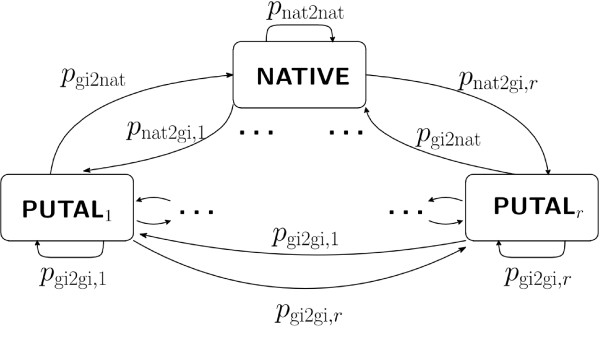
States and transition probabilities of SIGI-HMM's Markov chain. The state NATIVE represents genes which are unsuspicious with respect to synonymous codon frequencies. For ρ = 1, 2,..., r, the state PUTALρ models genes, whose codon usage resembles more the prevalences of genomes G
 MathType@MTEF@5@5@+=feaafiart1ev1aaatCvAUfKttLearuWrP9MDH5MBPbIqV92AaeXatLxBI9gBamrtHrhAL1wy0L2yHvtyaeHbnfgDOvwBHrxAJfwnaebbnrfifHhDYfgasaacH8akY=wiFfYdH8Gipec8Eeeu0xXdbba9frFj0=OqFfea0dXdd9vqai=hGuQ8kuc9pgc9s8qqaq=dirpe0xb9q8qiLsFr0=vr0=vr0dc8meaabaqaciaacaGaaeqabaWaaeGaeaaakeaaimaacqWFge=raaa@382D@ρ which represents taxon T
 MathType@MTEF@5@5@+=feaafiart1ev1aaatCvAUfKttLearuWrP9MDH5MBPbIqV92AaeXatLxBI9gBamrtHrhAL1wy0L2yHvtyaeHbnfgDOvwBHrxAJfwnaebbnrfifHhDYfgasaacH8akY=wiFfYdH8Gipec8Eeeu0xXdbba9frFj0=OqFfea0dXdd9vqai=hGuQ8kuc9pgc9s8qqaq=dirpe0xb9q8qiLsFr0=vr0=vr0dc8meaabaqaciaacaGaaeqabaWaaeGaeaaakeaaimaacqWFtepvaaa@3847@ρ. Each transition from state x to state y is characterized by its transition probability px2y. In order to model the mosaic structure of GI composition, transitions from any state PUTALρ to any other one PUTALσ are allowed.